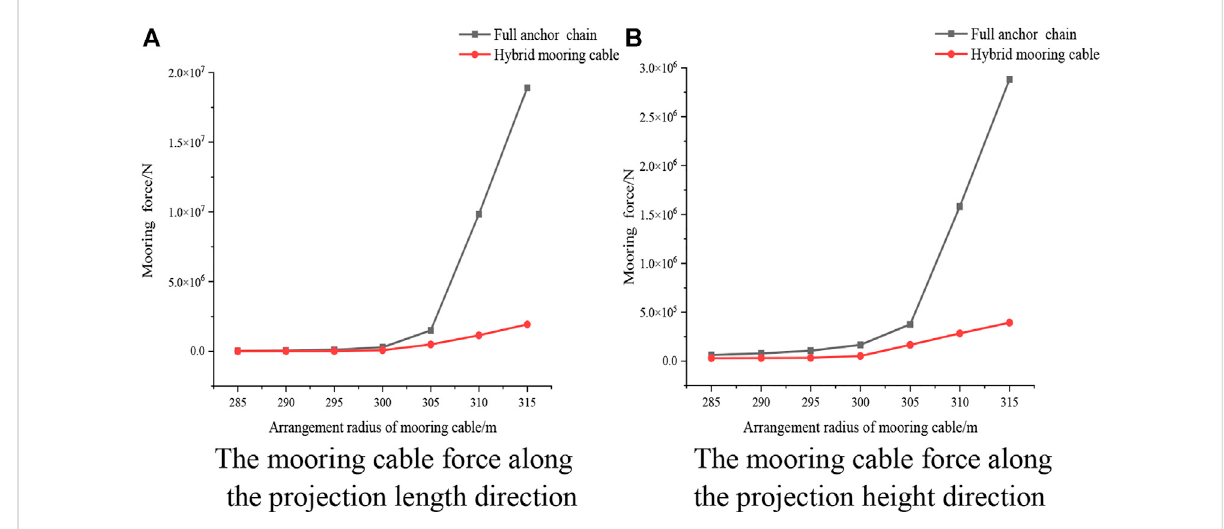
FIGURE 12 Single mooring cable projection lengthwise stiffness characteristics. (A) The mooring cable force along the projection length direction. (B) The mooring cable force along the projection height